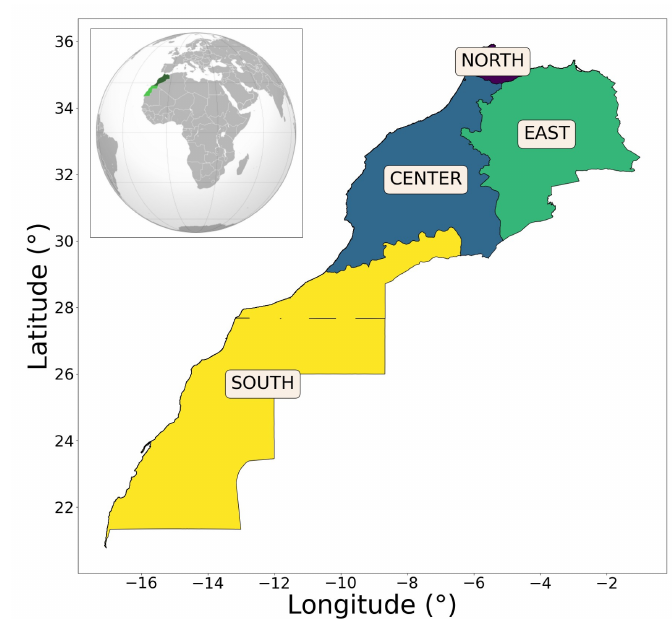
Figure 3. Morocco’s electrical zones. Inset: Morocco’s undisputed territory (dark green) and Western Sahara (green), a territory claimed and occupied by Morocco.